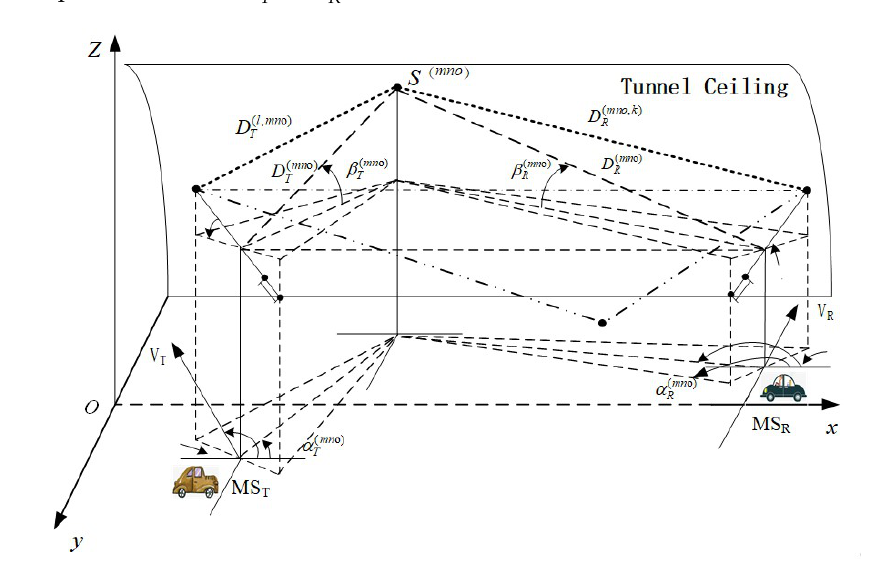
Figure 4. Geometrical scattering model for